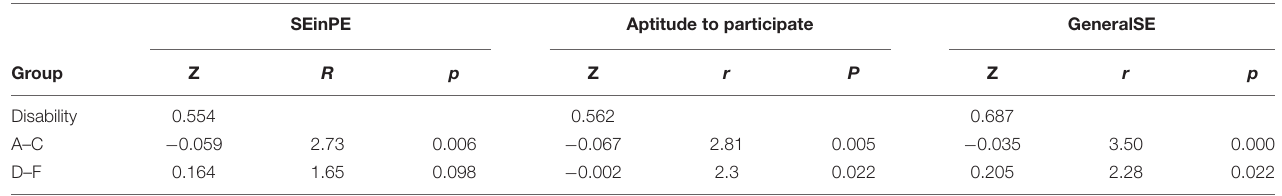
TABLE 5 | Fisher’s r to Z estimations of group differences at T2 between physical skills and PE-specific self-efficacy (SEinPE), aptitude to participate, and general school self-efficacy (GeneralSE). SEinPE Aptitude to participate